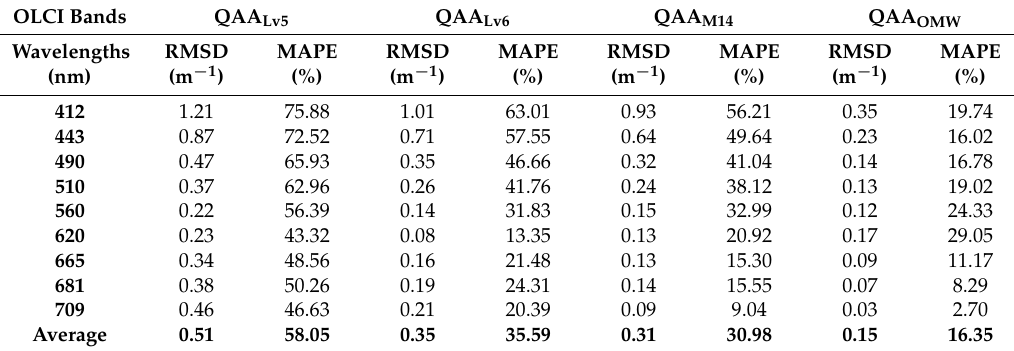
Table 4. Comparative band-specific errors related to the re-parameterization of a t ( λ ) based on mean absolute percentage error (MAPE) (%) and root square mean difference (RSMD) (m − 1 ) metrics. The first column represents the nominal OLCI center bands